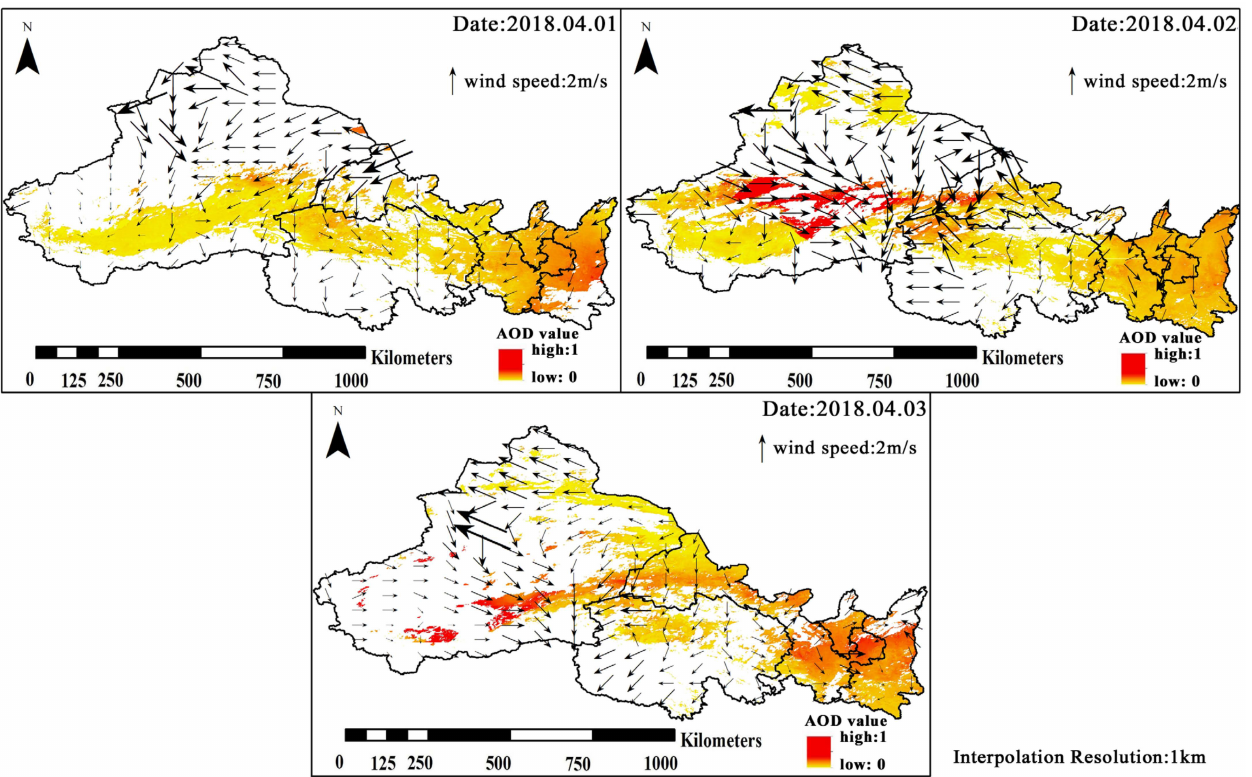
Figure 4. Spatial distribution of wind speed and wind direction during the period relevant to the sandstorm event in April 2018, for the case study